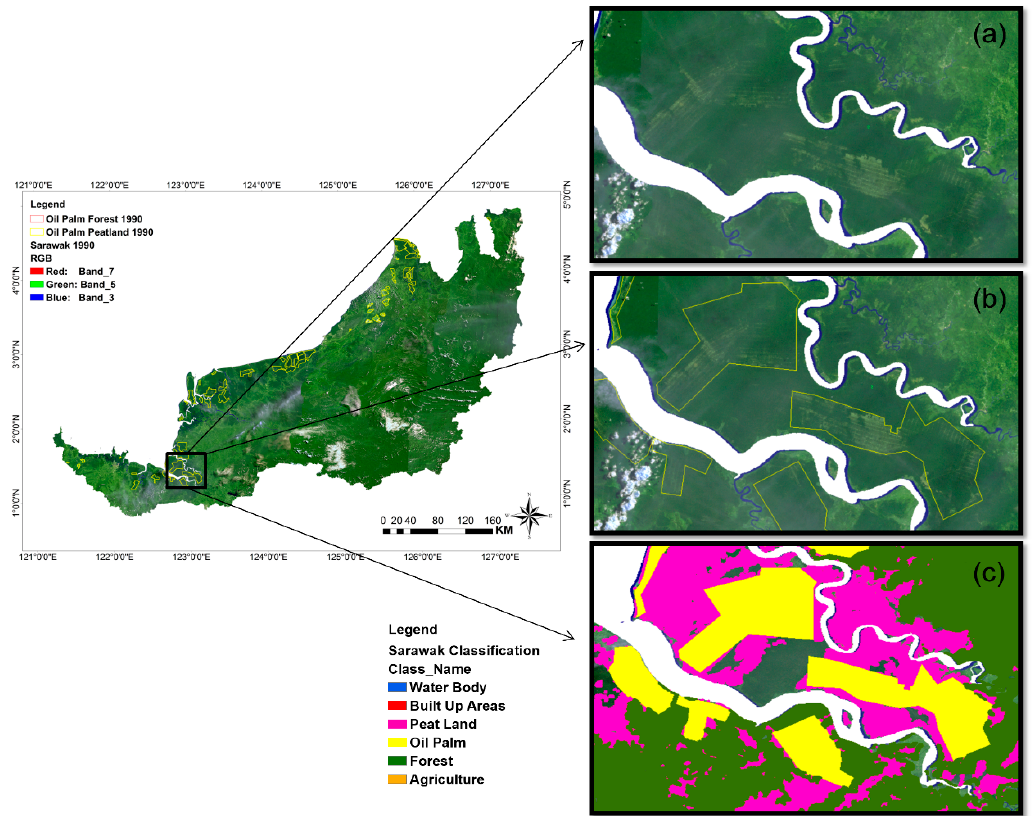
Figure 4. Training sample selection for digitizing oil palm plantation area based on visual interpretation on Landsat-5, Sarawak area in 1990; ( a ) empty scene, ( b ) selecting oil palm training sample, and ( c ) oil palm manual extraction polygon overlaid with overall classification